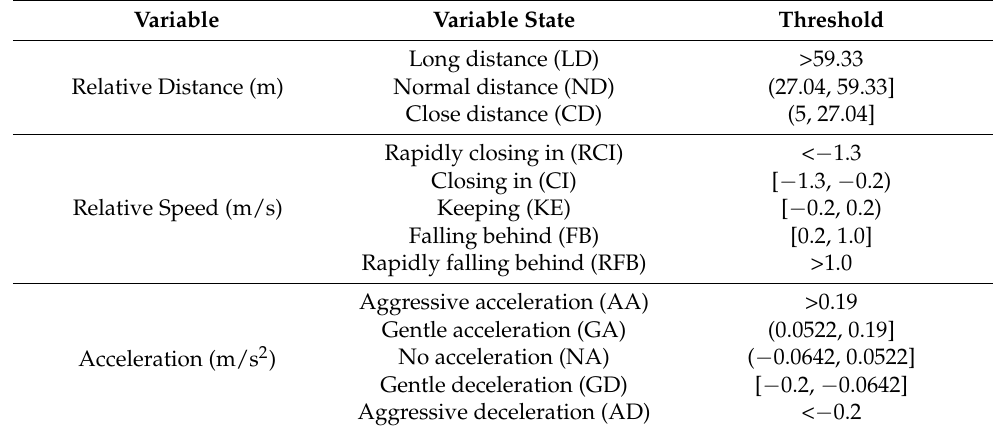
Table 1. Descriptions of the three feature variables.